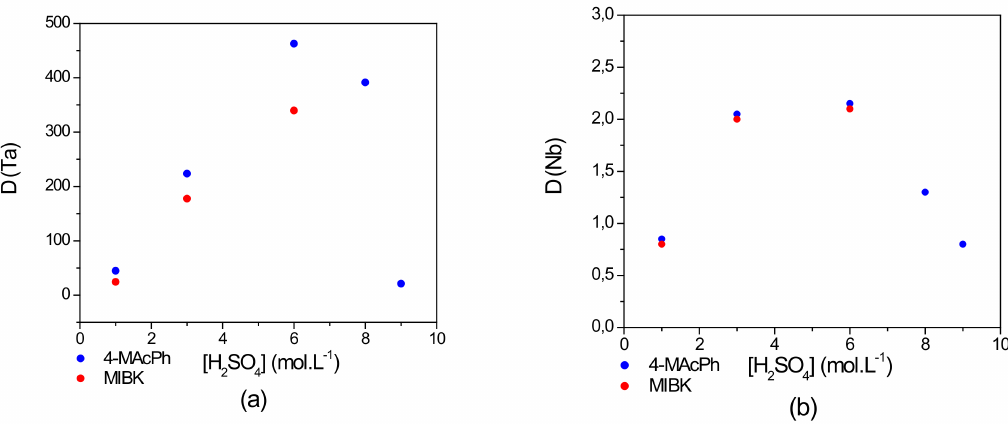
Figure 3. Effect of H 2 SO 4 concentration on the distribution coefficient D of ( a ) Ta and ( b ) Nb. Extraction conditions: O/A = 1; T = 22 ◦ C. Extraction time: 30 min. Organic phase (O): 4-MAcPh